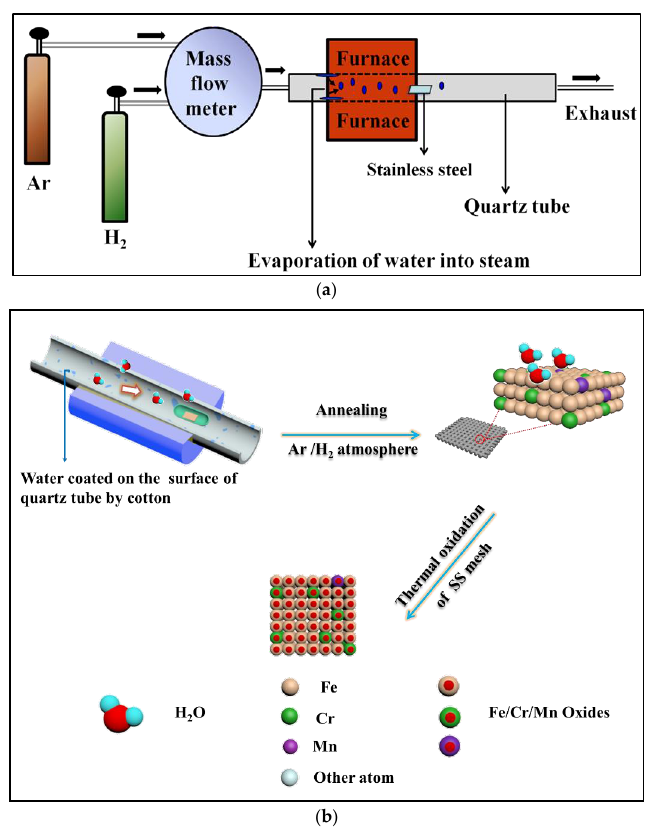
Figure 1. ( a ) Scheme illustration for the metal oxide nanosheets (MONs) grown in the tube furnace; ( b ) is the supplemental presentation of MONs growth process.